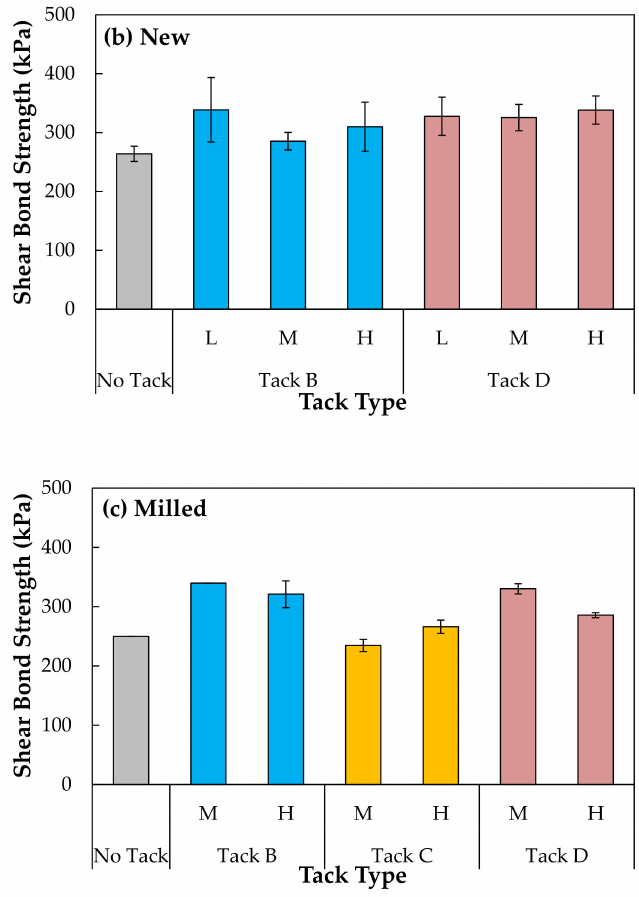
Figure 12. Effect of surface type, tack type, and residual tack rate on shear bond strength for field cores with different underlying layers in: ( a ) existing, ( b ) new, and ( c ) milled